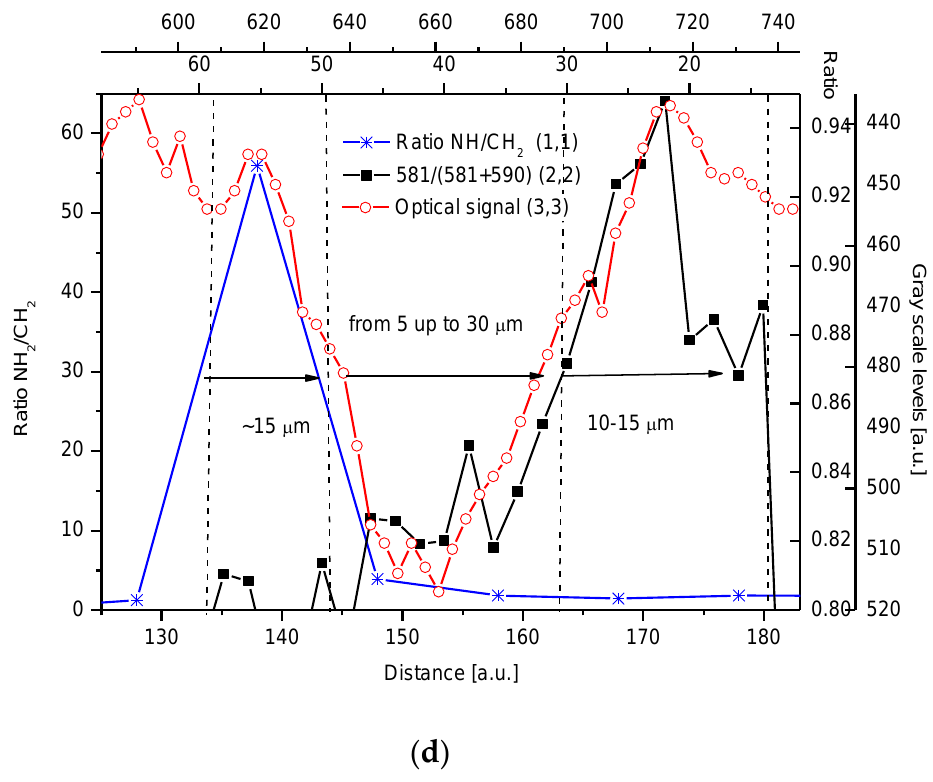
Figure 8. ( a ) The internal structure of the DEJ. Hardness and friction lines delimit here the DEJ zone. Mg is from EPMA and PIXE measurements and Na from EPMA measurements. Measurements were not made along the same line, but general tendencies are common. Values on y-axes were uniformized for better observation. ( b ) Superposition of the NH signal profile and the ratio of NH/CH 2 profiles on the optical outline of the DEJ and Raman measurements. ( c ) Profiles of single amino acids present in collagen bundles within DEJ. ( d ) Variabilities of ratios of NH/CH 2 and 581/(581 + 590) Raman lines mirroring left and right zones adhering to the DEJ. The DEJ can also be delimited based on µ -Raman measurements, with the optical